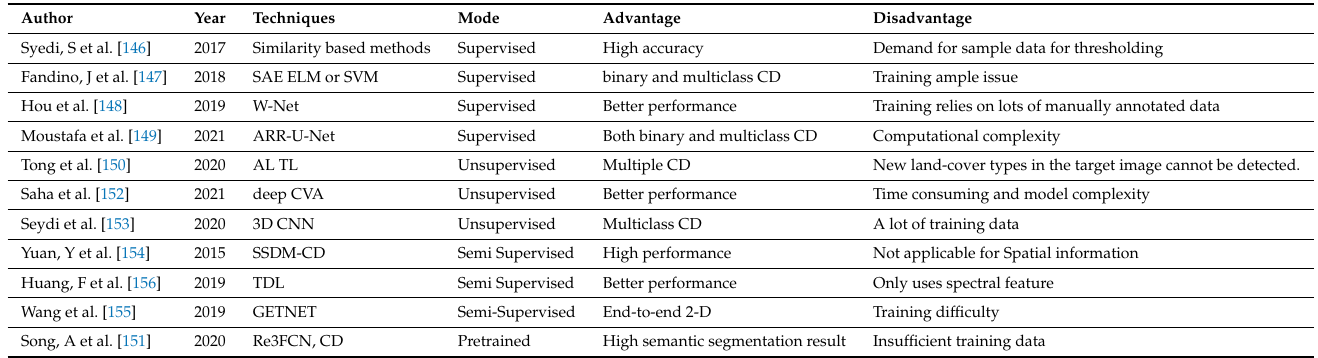
Table 11. Summary of the literature work of change detection techniques based on a hyperspectral image